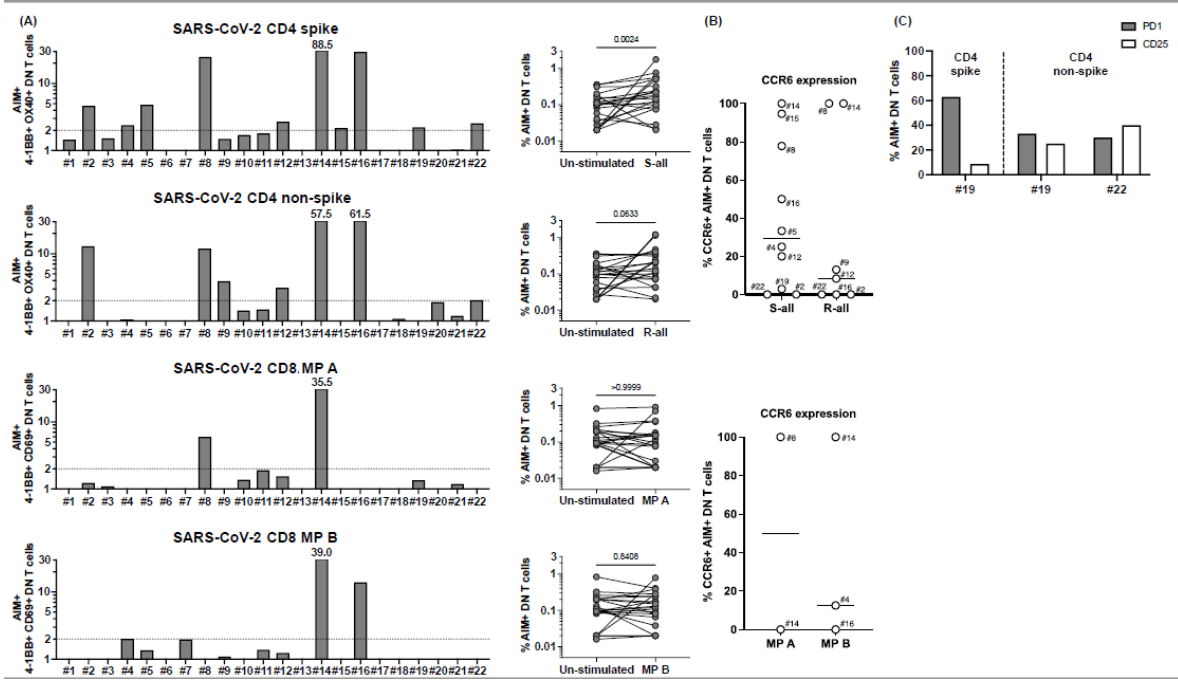
Figure 3. CD4 − CD8 − double-negative (DN) T cell responses to peptide megapools derived from SARS-CoV-2 in subacute MIS-C subjects. CD4 − CD8 − DN T cell responses were studied gated under CD3+ (T cells), followed by the gating of the CD4 − CD8 − population (see Supplementary Figure S1) in the 22 subacute MIS-C subjects. ( A ) DN T cell activation in response to SARS-CoV-2 peptide megapool stimulations. The percentages of 4-1BB+ OX40+ DN T cells were enumerated in unstimulated vehicle control, SARS-CoV-2 CD4 spike, and SARS-CoV-2 CD4 non-spike-stimulated cell cultures. In addition, the percentages of 4-1BB+ CD69+ DN T cells were enumerated in unstimu- lated vehicle control, SARS-CoV-2 CD8 MP A-, and MP B-stimulated cell cultures. SIs of AIM+ DN T cells from each individual subject are shown. Four subjects (4, 8, 14, and 16) of the 22 subjects showed DN T cell responses to both CD4 and CD8 peptide megapools. Seven subjects (2, 5, 9, 12, 15, 19, and 22) of the 22 MIS-C subjects showed DN T cell responses to only CD4 peptide megapools. No subject showed DN T cell responses to only CD8 peptide megapools, and 11 subjects (1, 3, 6, 7, 10, 11, 13, 17, 18, 20, and 21) of the 22 MIS-C subjects showed no measurable DN T cell response. ( B ) CCR6 expression on SARS-CoV-2-specific DN T cells. AIM+ DN T cells showed a different level of CCR6 expression from subject to subject. ( C ) PD1 and CD25 expression on SARS-CoV-2-specific DN T cells. PD1 and CD25 expressions were studied on 4 subjects (19–22). Subject 19 showed DN T cell responses to both CD4 spike and nonspike peptide megapools, and subject 22 showed DN T cell responses to a CD4 nonspike peptide megapool. Percentages of PD1+ (grey bars) and CD25+ (white bars) were enumerated under AIM+ DN T cells in the cell cultures, which showed a positive response to the peptide megapool. While 30.0–62.9% of the AIM+ DN T cells expressed PD1, 8.6–40.0% of the AIM+ DN T cells also showed CD25 expression. Each symbol represents data derived from each individual subject. Comparisons of the percentages of AIM+ DN T cells between unstimulated control and peptide megapool-stimulated cell cultures were tested by the Wilcoxon signed-rank